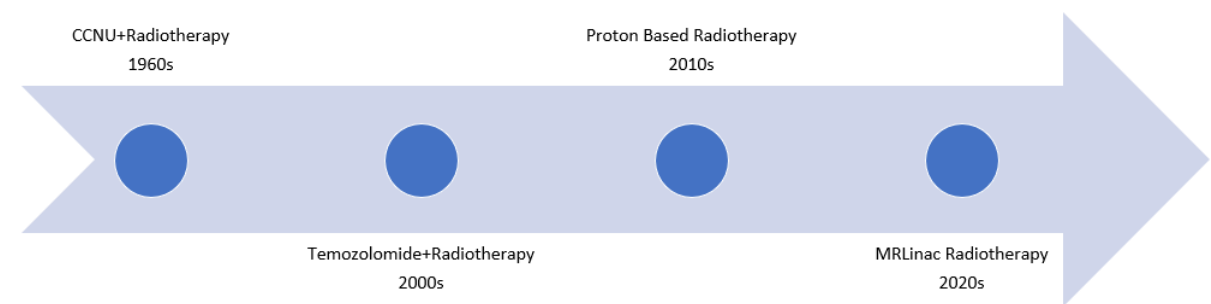
Figure 4. As far back as the 1960s and 1970s there have been clinical trials examining the role of systemic therapy combined with radiotherapy. Notably, the Walker Series first examined combining CCNU and radiotherapy in the Brain Tumor Study Group protocols BTSG 66-01, 69-01, 72-01. More recently, the Stupp trial changed the standard of care to include Temozolomide concurrently with radiotherapy. As technological advancements have been made, there has also been an interest in the potential role of proton based radiotherapy, which is being explored in the BN001 trial. Finally,